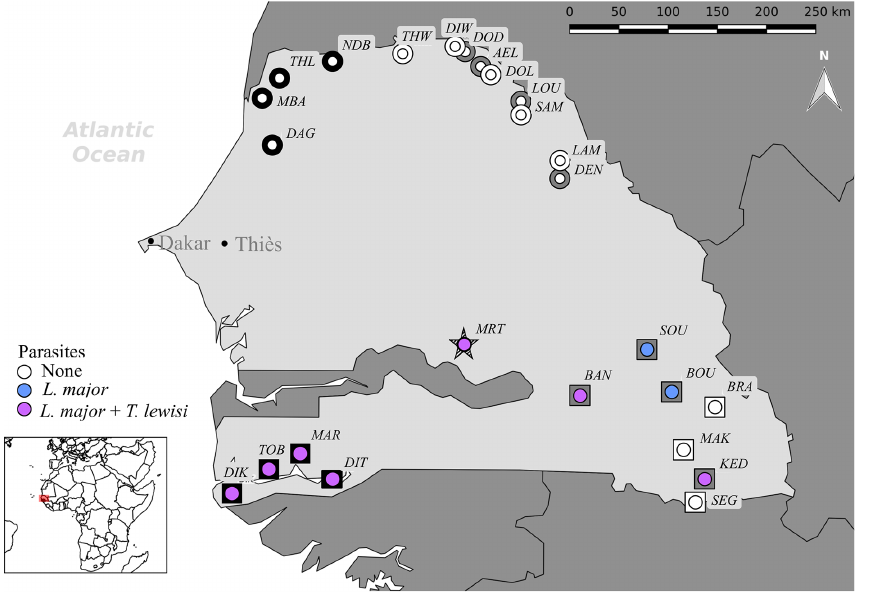
Fig 1. Rodent sampling localities along the house mouse ( Mus musculusdomesticus ) (circles) and black rat ( Rattus rattus )(squares) invasion gradients in Senegal (West Africa). Colour code: black for localities of long-established invasion (LI: rodent communities dominated by invasive species); grey for recently invaded localities or the invasion front (IF: sympatric areas with invasive rodents and native Mastomys erythroleucus ,or Mastomys natalensis in KED); white for non-invaded localities (NI: only native rodents, Ma . erythroleucus in the north, Ma . natalensis in the south). Presence (blue dots for Leishmania major ; violet dots for Trypanosoma lewisi + L . major ) and absence (white dots) of parasites in the rodent species are also indicated. AEL = Aere Lao, BAN = Badi Nieriko, BOU = Boutougoufara, BRA = Bransan, DAG = Dagathie, DEN = Dendoudi, DIK = Diakène Wolof, DIT = Diattacounda, DIW = Diomandiou Walo, DOD = Dodel, DOL = Doumga Lao, GAL = Galoya, KED = Kedougou, LAM = Lambango, LOU = Lougue, MAK = Mako, MAR = Marsassoum, MBA = Mbakhana, NDB = Ndombo, SAM = Sare Maounde´, SEG = Segou, SOU = Soutouta, THL = Thilene, THW = Thiewle´, TOB = Tobor. MRT (= Mereto; hatched star) is invaded by both M . m . domesticus and R . rattus . The map was created using the QGIS software v. 2.18.7